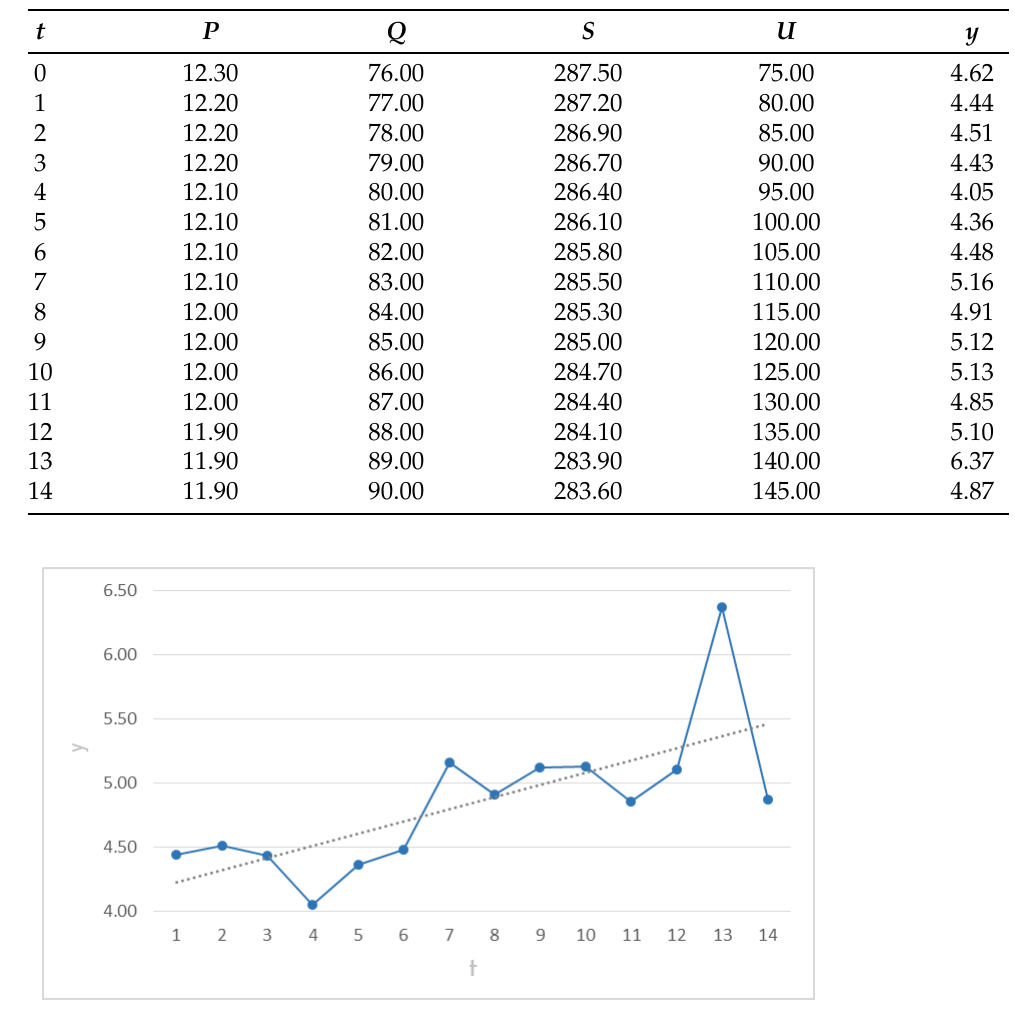
Figure 3. Graph with the steepest ascent path of the response Y with a straight line, which assumes normality in Case 1. Table 2. Obtained limits of MKR in Case